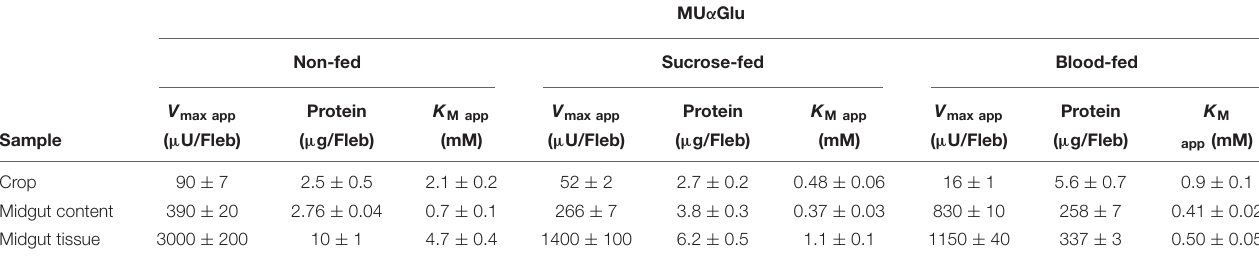
TABLE 3 | Kinetic parameters of α -glucosidase activities obtained from different samples of L. longipalpis females under different physiological conditions, using MU α Glu as